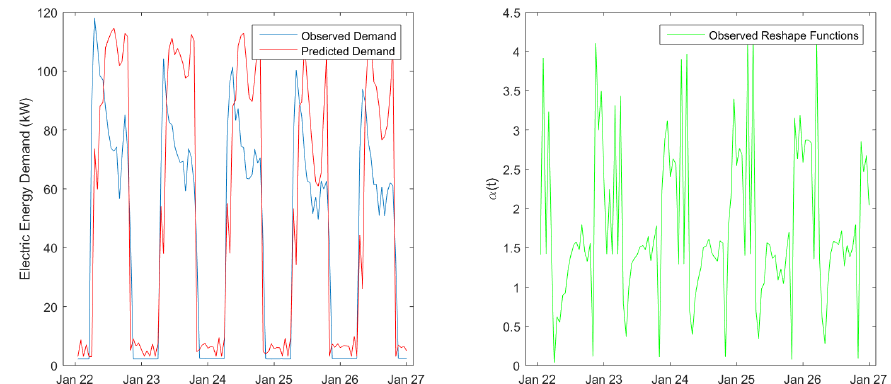
Figure 2. Example of the observed and simulated daily energy demand (per hour) and the corresponding reshape functions for the time period 22/01/2018 to